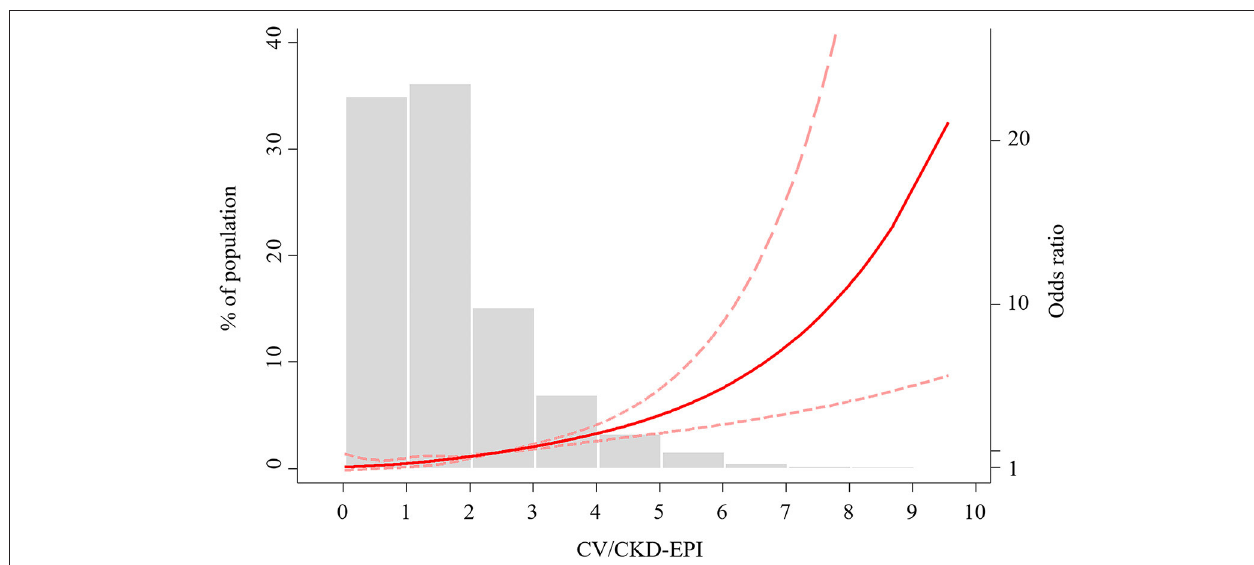
FIGURE 2 | Restricted cubic spline of CV/CKD-EPI ratio and CIN. CV/CKD-EPI, contrast volume to chronic kidney disease epidemiology collaboration; CIN, contrast-induced nephropathy; OR, odds ratio.